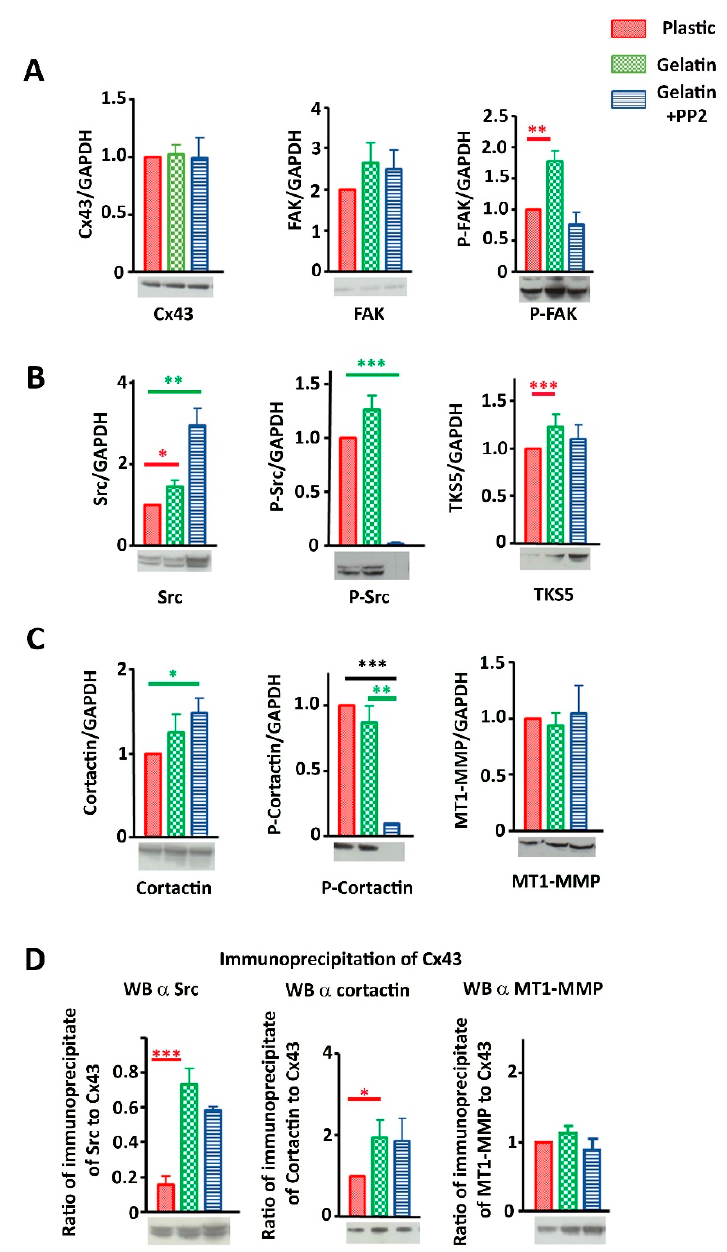
Figure 4. Protein (Cx43, FAK, P-FAK, Src, P-Src, cortactin, P-cortactin, TKS5 and MT1-MMP) expressions and interactions in correlation with Cx43 expression. ( A ) Densitometric analysis of Cx43 (left), FAK (middle) and P-FAK (right) expression levels after normalization by GAPDH expression. ( B ) Densitometric analysis of Src (left), P-Src (middle) and TKS5 (right) protein expression level after normalization to GAPDH levels according to Cx43 expression level (N = 5). ( C ) Densitometric analysis of cortactin (left), P-cortactin (middle) and MT-MMP (right) protein expression levels after normalization by GAPDH expression (N = 4). ( D ) Ratio of immunoprecipitation of Cx43 from U251 cells and immunoblotting of Src (N = 3), immunoblotting of cortactin (N = 5) or immunoblotting of MT1-MMP (N = 5). Red bar highlights differences due to gelatin culture condition and black bar highlights differences due to Cx43 expression diminution. Green bar highlights differences due to PP2 exposition. * p < 0.05; ** p < 0.01 and *** p < 0.001. Values shown as mean ± SEM (see Supplementary Table S1).